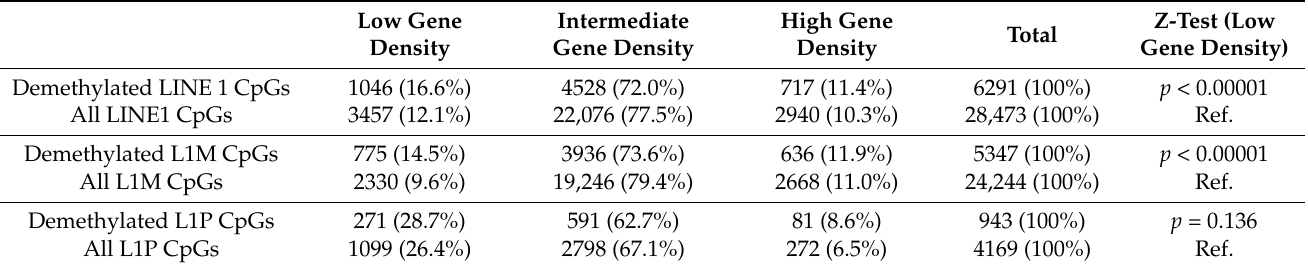
Table 2. LINE1 subfamily distributions of demethylated CpGs, respectively in areas of low (0–10 genes/Mb), intermediate (11–50 genes/Mb), and high gene density (>50 genes/Mb). Z-Test (Low Low Gene Intermediate High Gene Total Gene Density) Density Gene Density Density